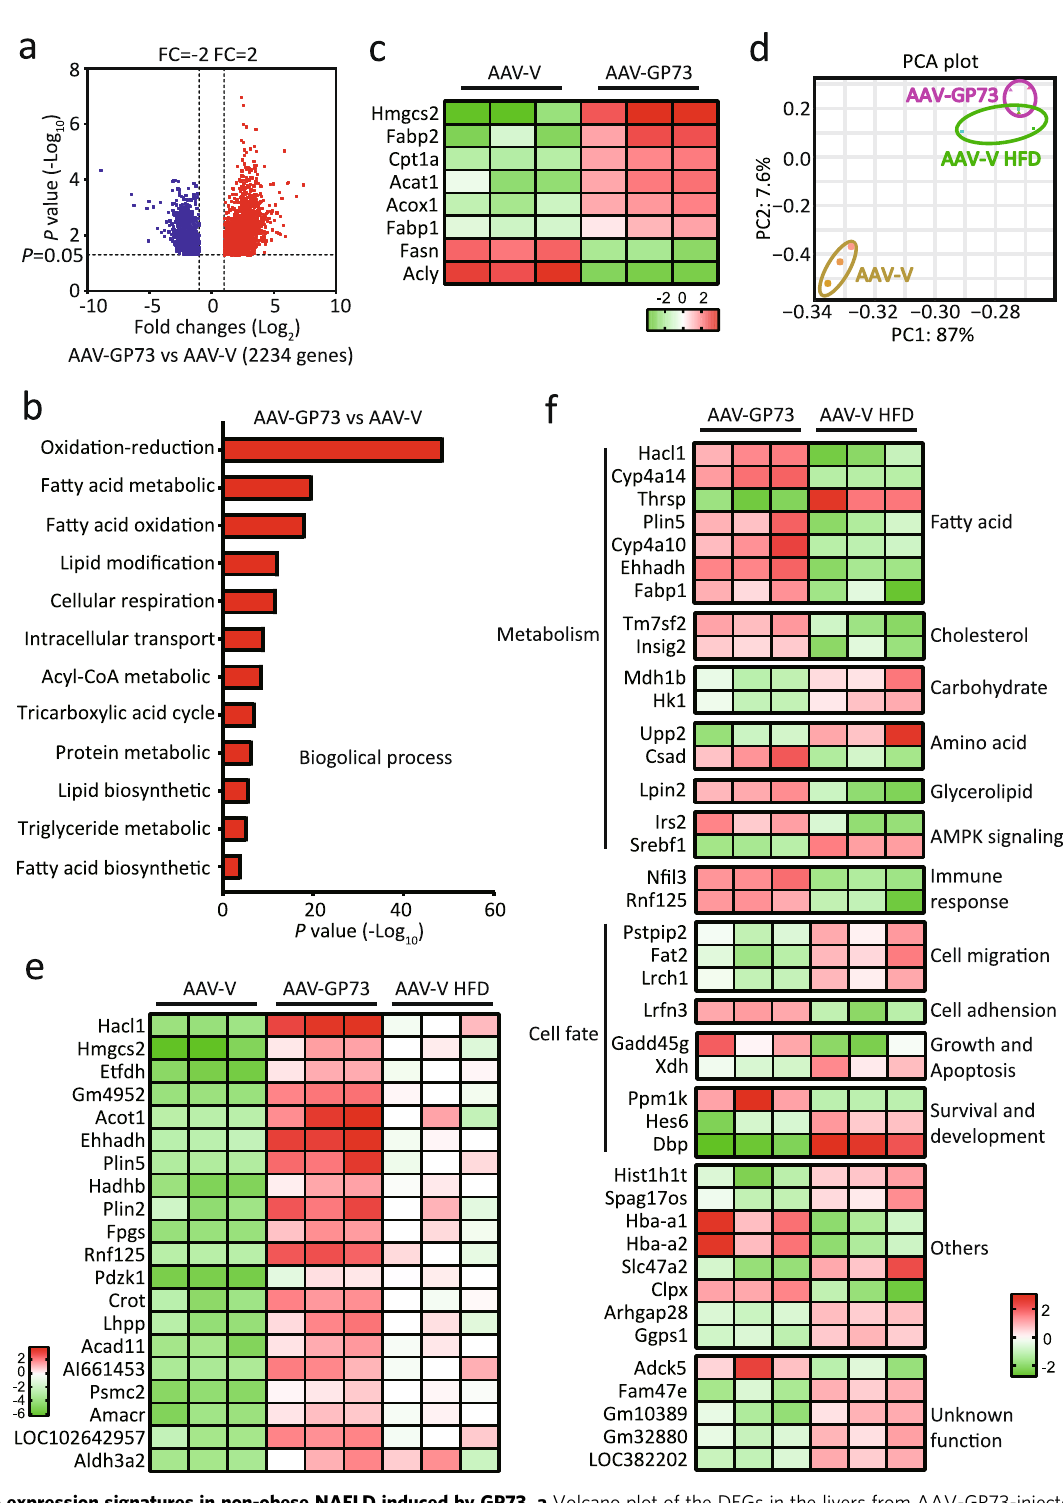
Fig. 4 Gene expression signatures in non-obese NAFLD induced by GP73. a Volcano plot of the DEGs in the livers from AAV-GP73-injected mice fed a regular diet for 12 months ( n = 3 per group). Signi fi cantly downregulated genes are in blue, and signi fi cantly upregulated genes are in red. The data were analyzed with two-sided Student ’ s t -test. The black vertical lines highlight fold changes (FCs) of − 2 and 2, while the black horizontal line represents a P value of 0.05. b Pathways enriched for the DEGs in the livers from AAV-GP73-injected mice at 12 months after injection ( n = 3 per group) according to GO term analysis at GO level 4. The bar plot shows signi fi cantly dysregulated pathways, and Fisher ’ s exact test P values are shown on the x -axis. c Heatmap of the critical DEGs in the livers from AAV-GP73-injected mice versus AAV-V-injected mice fed a regular diet for 12 months. Upregulated genes are highlighted in red, and downregulated genes are highlighted in green. d PCA results. PCA was based on the gene expression patterns in the AAV-V (yellow), AAV-GP73 (purple), and AAV-V HFD (green) groups. In all plots, each point represents a sample. e Heatmap of the top 20 highly upregulated genes in the livers from the AAV-GP73 and HFD groups. f Heatmap of the top 20 highly upregulated and 20 highly downregulated genes that were speci fi cally regulated by